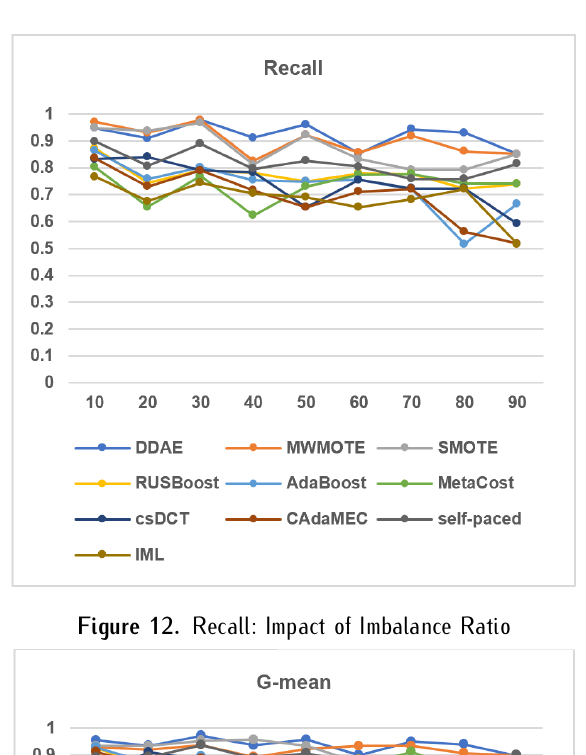
Figure 14. F1: Impact of Imbalance Ratio